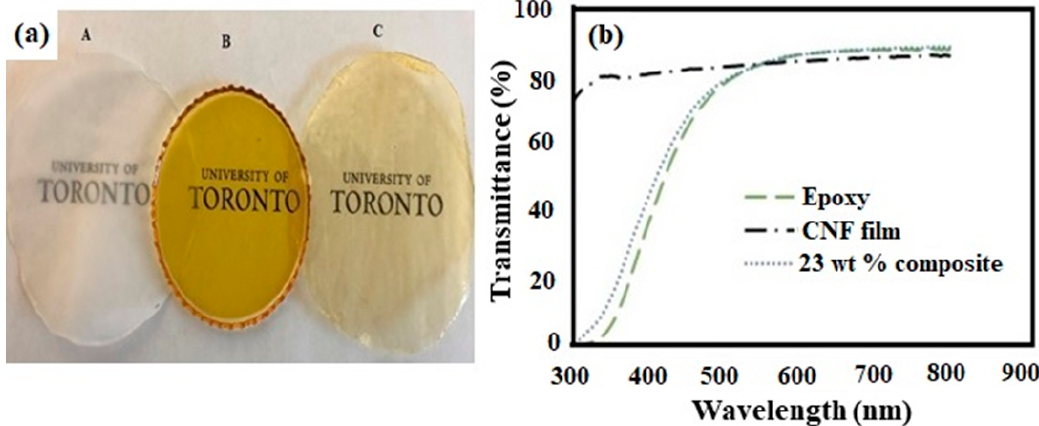
Figure 6. ( a ) Images of pure CNF (A), cured epoxy resin only (B), and the 23 wt % composite film (C). ( b ) Light transmittance measurements versus the wavelength for pure CNF, the cured epoxy resin, and the 23 wt % composite.